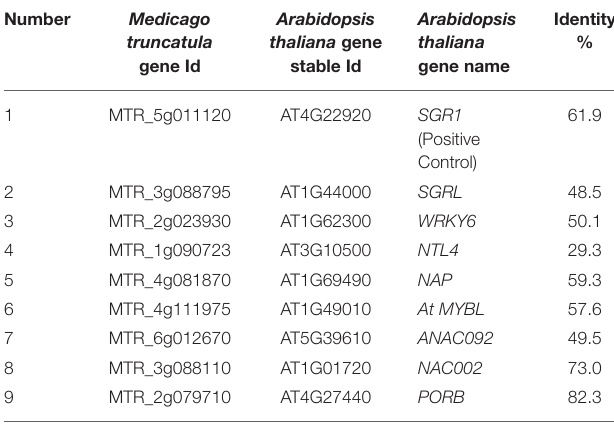
TABLE 2 | Screening of TFs for gene function